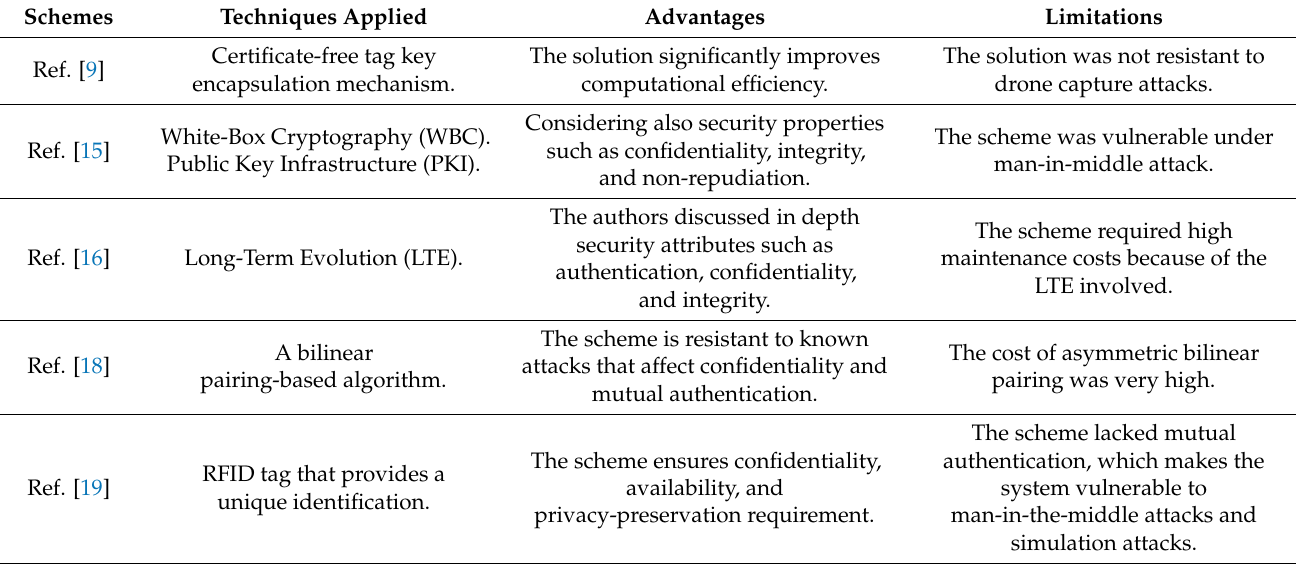
Table 1. The summary of the related